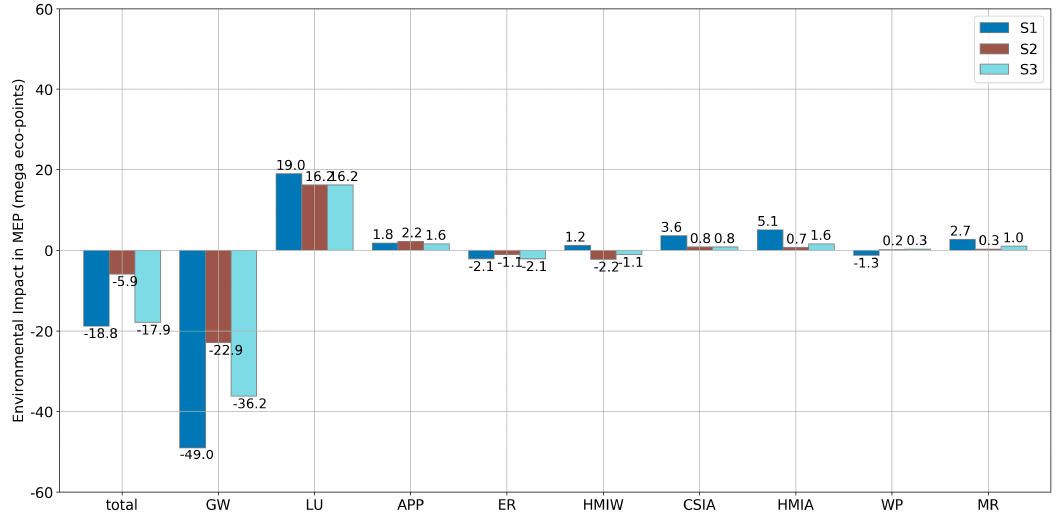
Figure 5. Absolute changes (as differences expressed in MEP = 1e6 EP) of the alternative renewable scenarios compared to BAU, only significant changes considered: GW = global warming, LU = land use, APP = main air pollutants and PM, ER = energy resources, HMIW = heavy metals into water, CSIA = carcinogenic substances into air, HMIA = heavy metals into air, WP = water pollutants, MR = mineral resources.